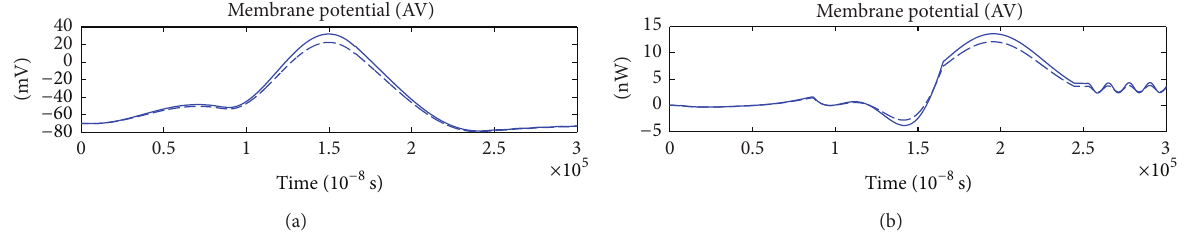
Figure 9: The action potential and its energy function. 𝑟 0𝑚 = 0.0001 Ω , 𝑟 1𝑚 = 0.1 Ω , 𝑟 2𝑚 = 1000 Ω , 𝑟 3𝑚 = 0.1 Ω , 𝑟 𝑚 = 1000 Ω , 𝐶 𝑚 = 1 𝜇 F, = 50 𝜇 H, 𝑖 = 70.7 𝜇 A, and 𝑄 = 6 × 10 −6 𝜇 A. 𝐿 𝑚 0𝑚